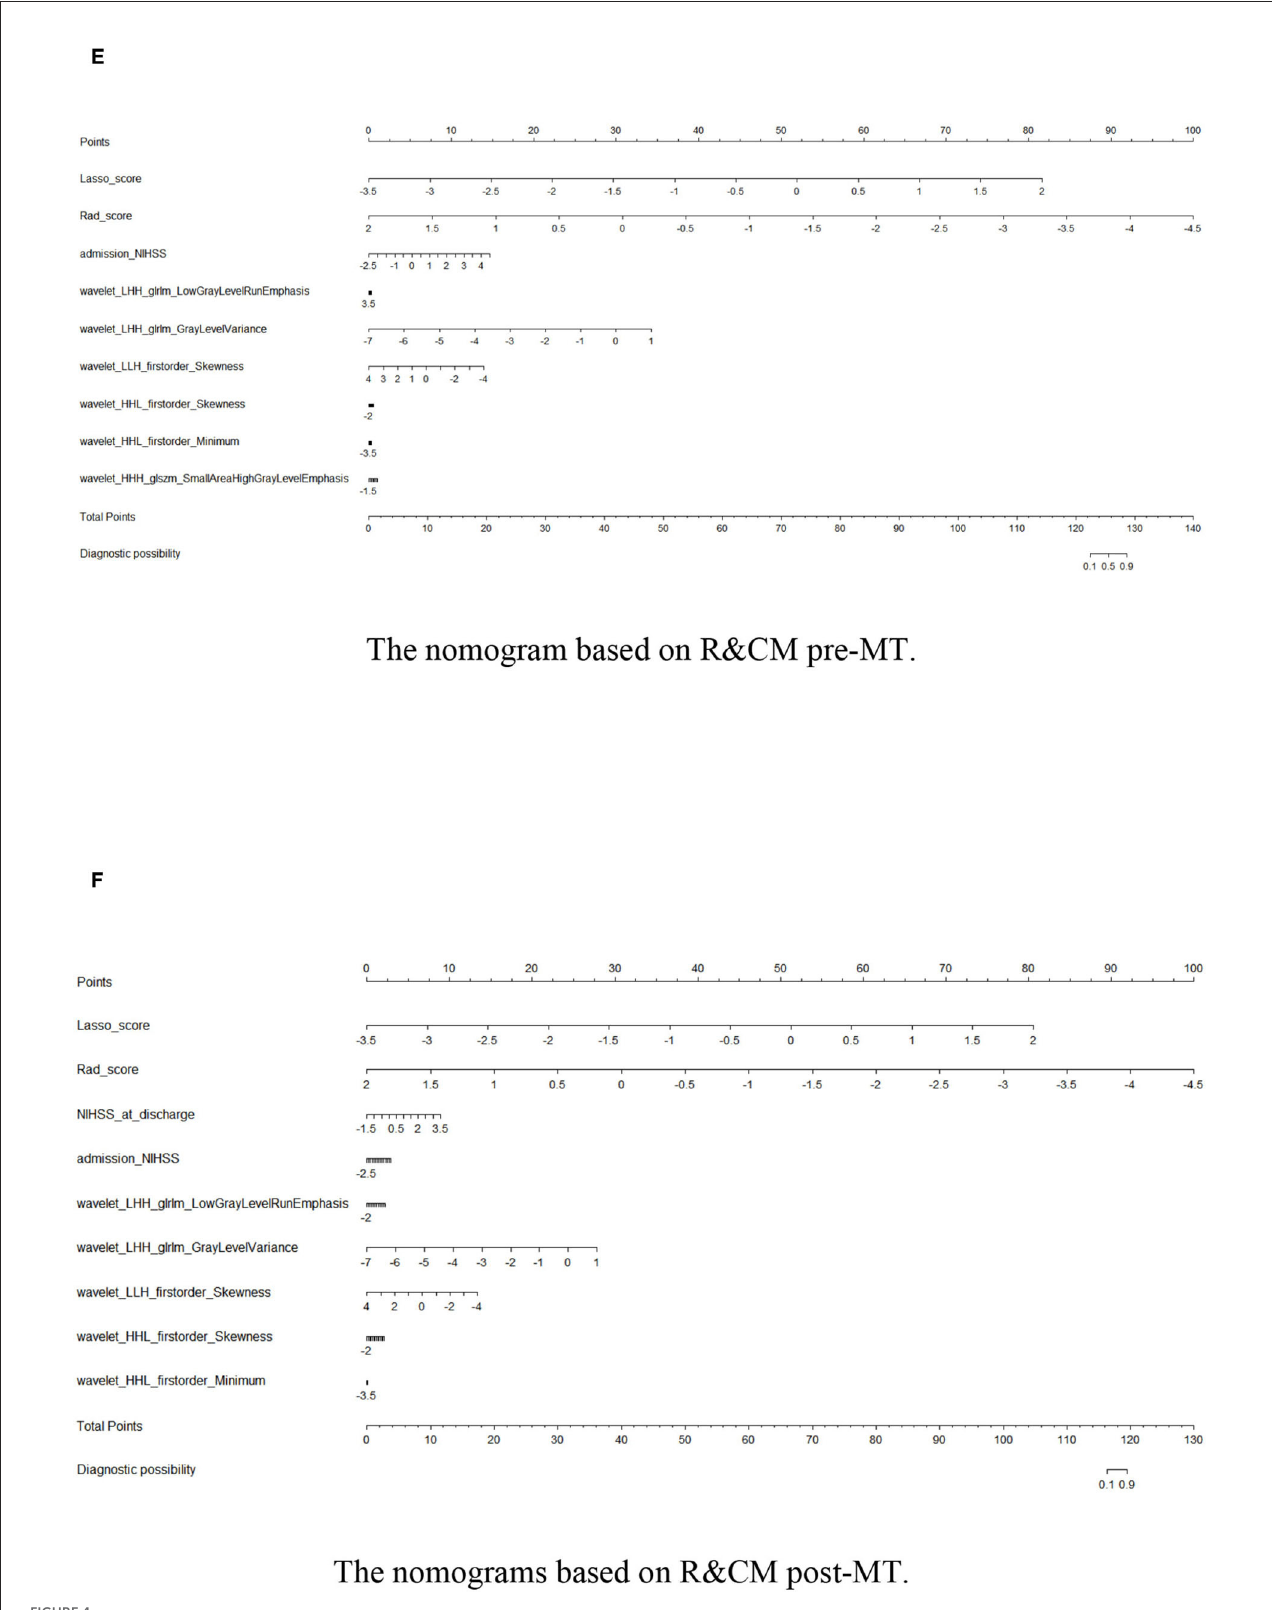
FIGURE4 Integration of related results of five models. (A) The ROC curves of five models in cross-validation set and test set, respectively. (B) The DCA curves of the five models in the test set. When the high-risk threshold is greater than 0.5, 4 DCA curves are higher than positive curves, indicating that the four